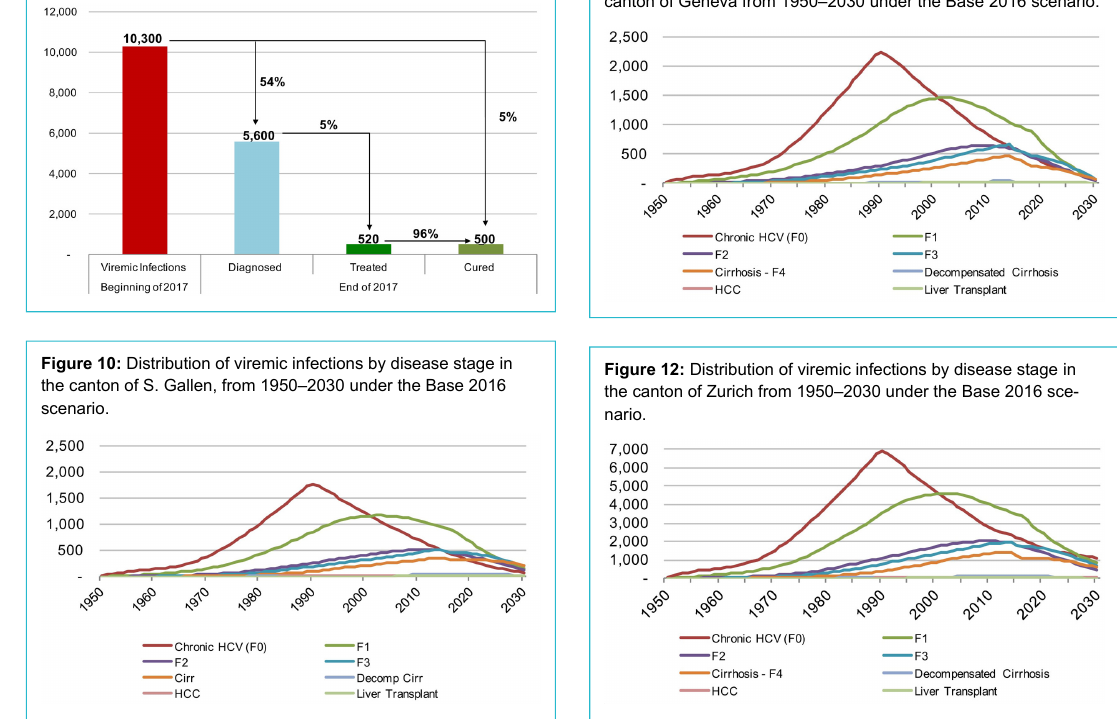
Figure 9: The hepatitis C cascade of care, including total viremic infections, diagnosed, treated and cured, in the canton of Zurich for 2017.